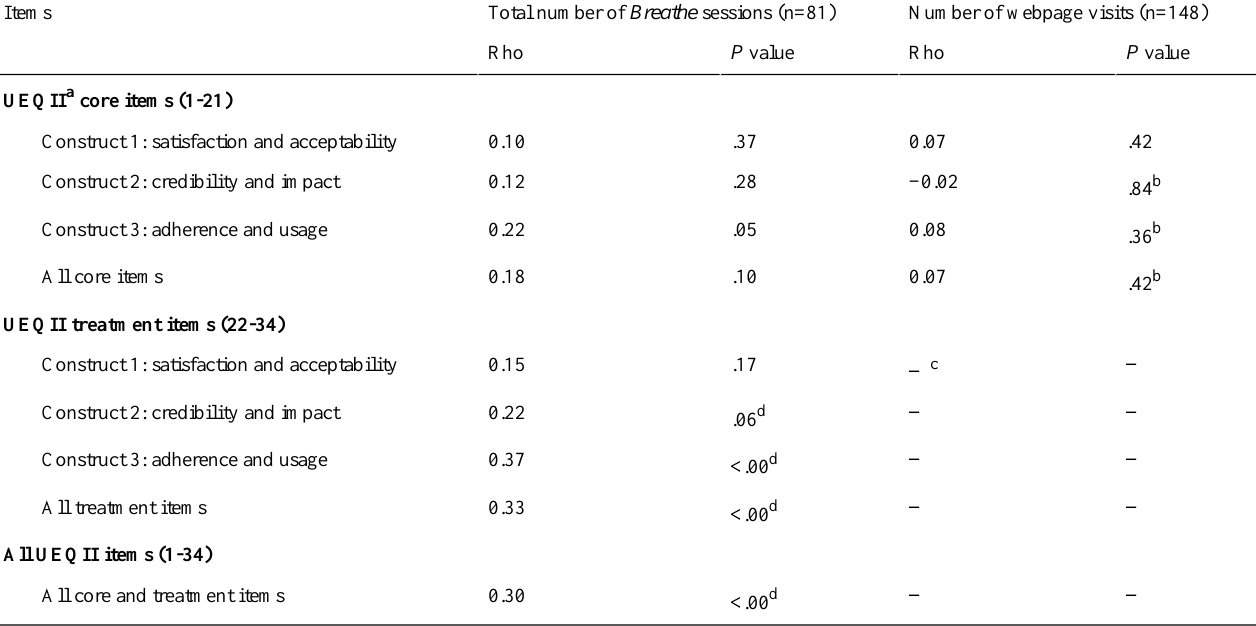
Table 11. The relationship between intervention usage and the user experience of Breathe and webpage